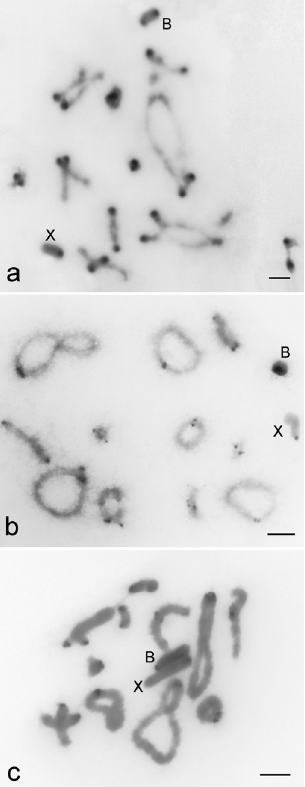
Figure 1. C-banding revealing the heterochromatin location in diplotene chromosomes of Rhammatocerus brasiliensis ( a ), Schistocerca rubiginosa ( b ), and Xyleus discoideus angulatus ( c ). Note the pericentromeric location of C-positive blocks on A chromosomes and the distinct patterns for the B chromosome of the three species, i.e., pericentromeric and distal in R. brasiliensis ; pericentromeric and interstitial (close to the centromere) in S. rubiginosa ; along the entire chromosome with darker band in pericentromeric region in X. d. angulatus . The X and B chromosomes are indicated. Bar = 5 μ m.